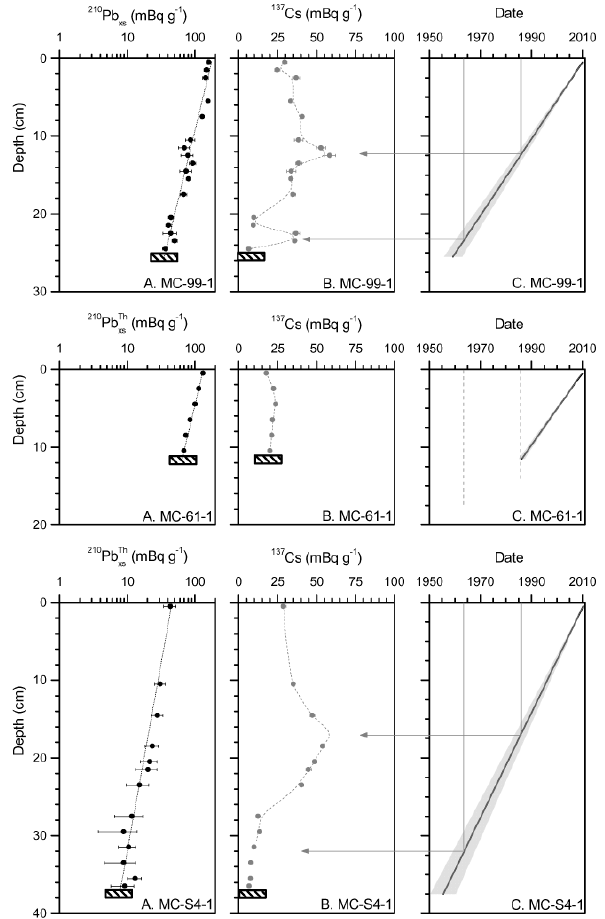
Fig. 3. Core chronology of MC 61-1 (centre) at the fjord entrance, MC 99-1 (top) in the Seaward Basin and MC S4-1 (bottom) in the Middle Fjord, showing (A) 210 Pb xs or 210 Pb xsTh (i.e. 210 Pb xs nor- malized to 232 Th, explanation in the text) profiles, (B) 137 Cs pro- files (except for MC 61-1) and (C) calculated ages based on the CF:CS model. The arrows indicate the expected position of the 137 Cs peaks related to maximum weapon test atmospheric fallout and the Chernobyl accident according to the chronology based on 210 Pb xs .